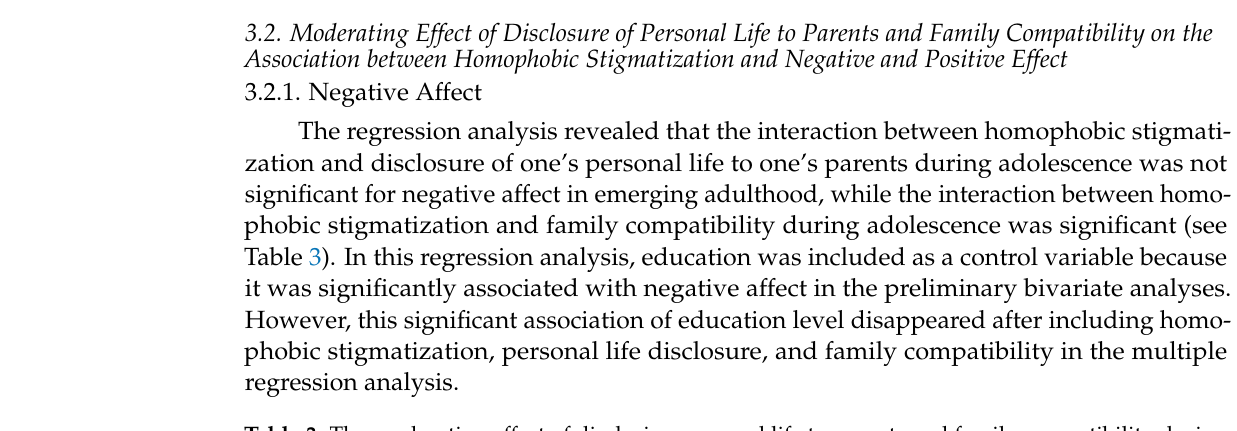
Table 3. The moderating effect of disclosing personal life to parents and family compatibility during adolescence (Wave 5) on the relationship between homophobic stigmatization during adolescence (Wave 5) and negative affect during emerging adulthood (Wave